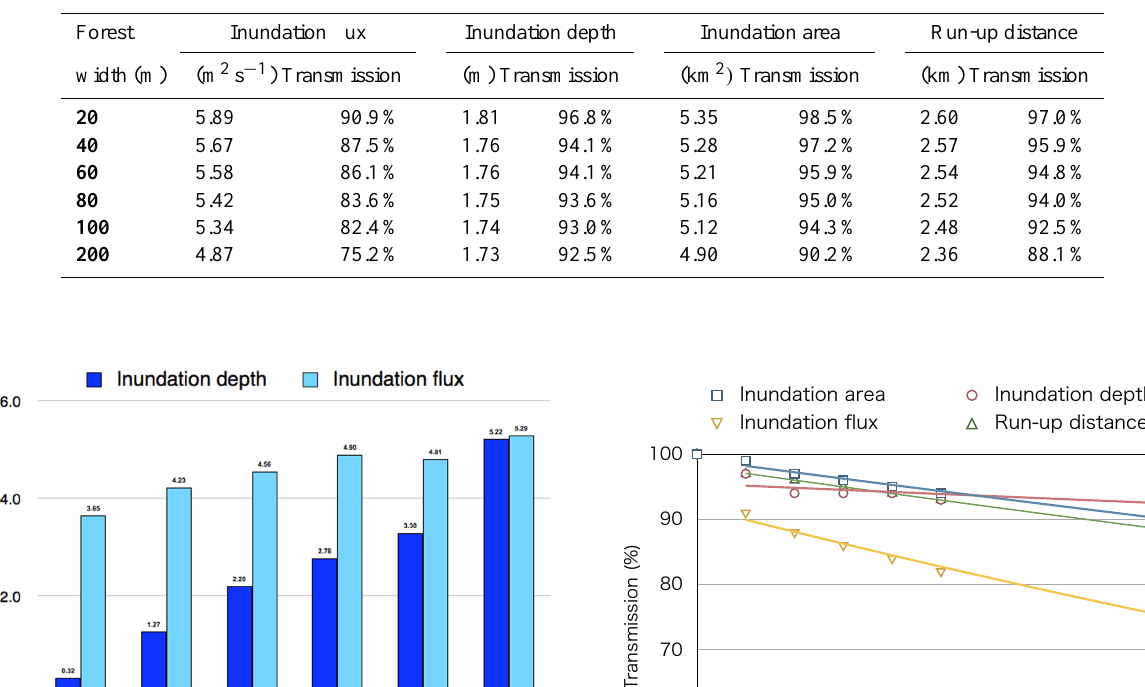
Fig. 9. The damping performance of forest for inundation flux around the forest. Table 4. The forest widths and the transmission.